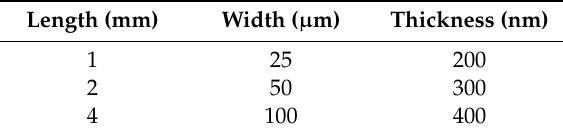
Table 1. Dimensions used in the experiments.